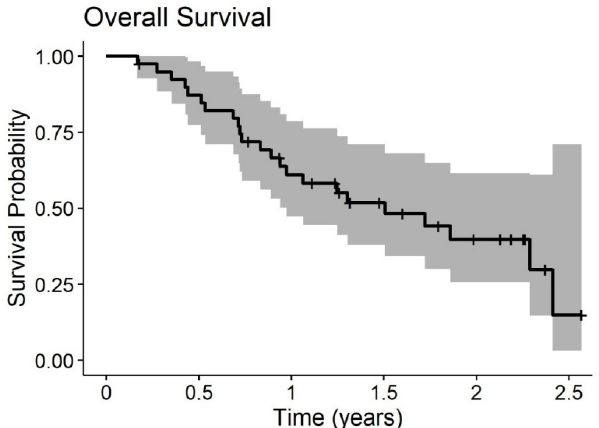
Figure 2. Overall survival of 20 patients with peritoneal carcinomatosis (PC) treated with at least two PIPAC procedures.